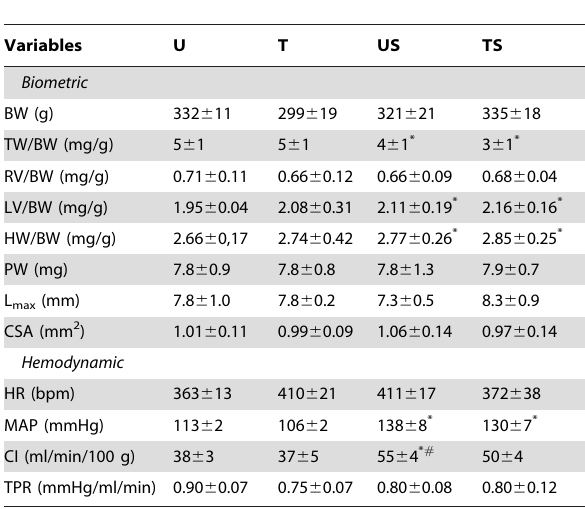
Table 1. Effects on biometric, hemodynamic and contractile parameters by association of anabolic steroid and exercise